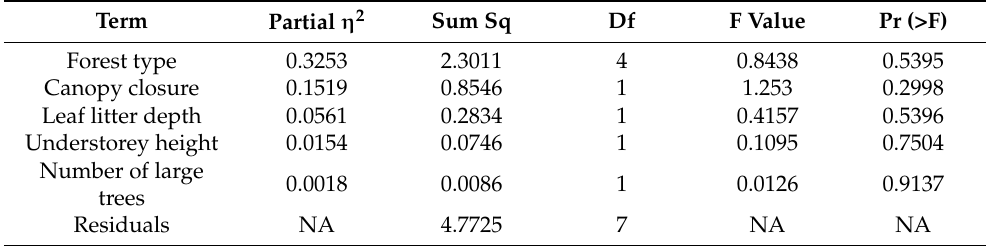
Table 4. Effect sizes and ANOVA table derived from the linear model estimating the effect of forest type and habitat characteristics on species richness of fireflies. Effect sizes >0.3 are deemed large.